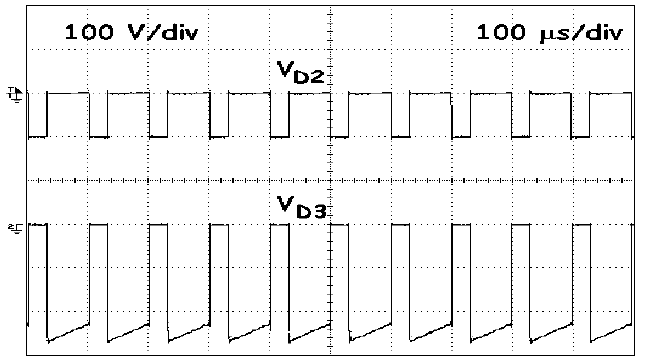
Figure 23. Experimental results for the voltage across the diodes D 2 and D 3 in boost mode.